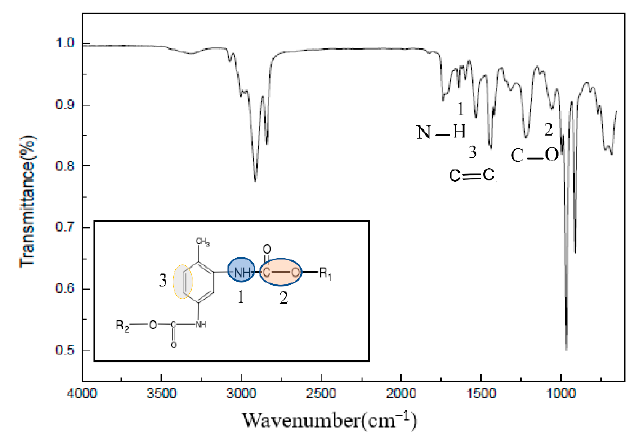
shown in Figure 7. The stretching vibration peak of C–O was at 1076 cm − 1 , the vibration peak of C=C on the benzene ring was at 1533 cm − 1 and the N–H vibration peak was at 1537 cm − 1 .